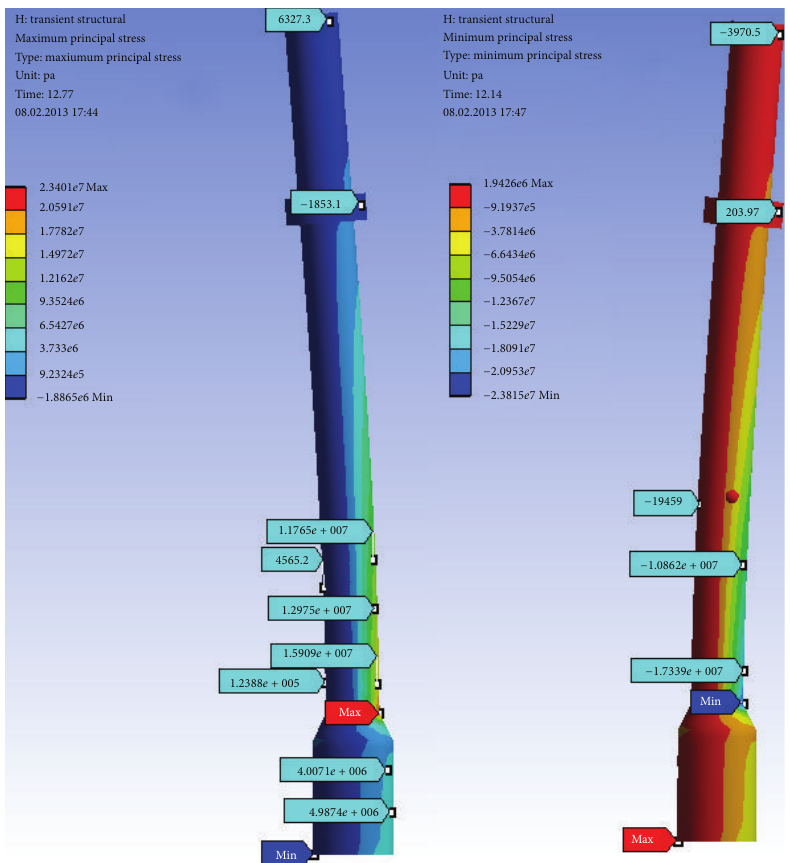
Figure 15: Maximum and minimum principal stress distribution for bare minaret model under the effect of scaled Duzce record (in